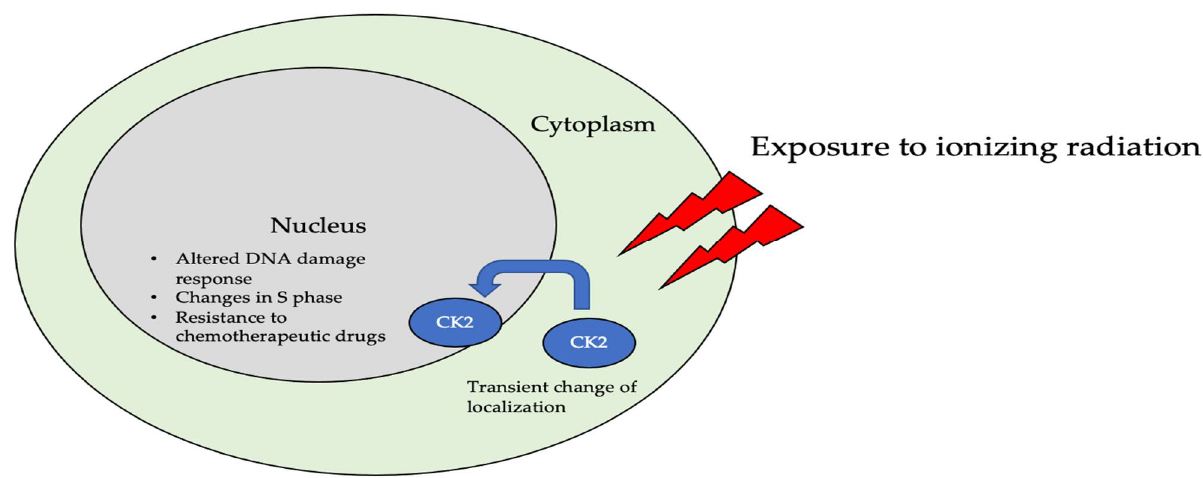
Figure 3. The localization of CK2 changes when cells are exposed to ionizing radiation (IR). Specifically, CK2α is translocated from the cytoplasm to the nucleus in multiple cell lines, including A549, H460, PC9, and M059K. Further, upon radiation exposure, the overall kinase activity of CK2 increases, emphasizing its role in the DNA-damage-repair response, as it colocalizes with DNA in the nucleus of cells.